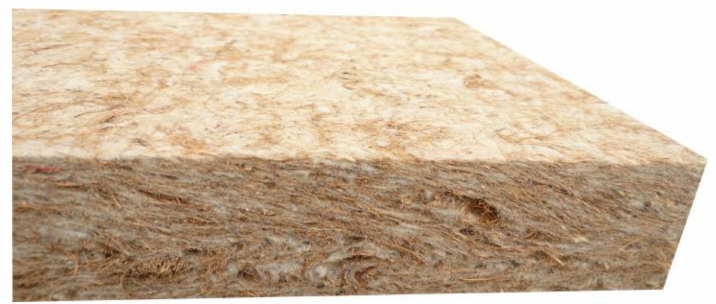
Figure 2. IsolKenaf panels-www.euchora.com (accessed on 26 July 2021).